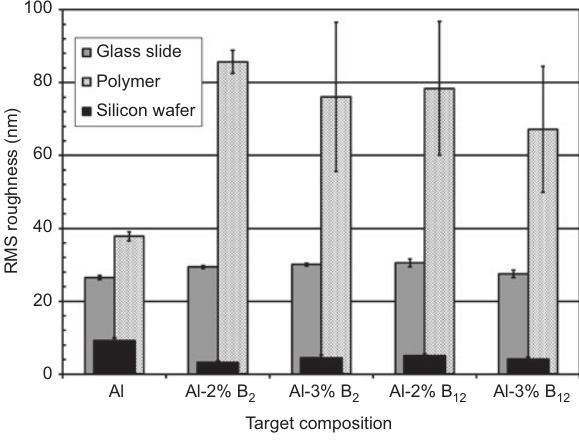
Figure 5 Roughness of the deposited fi